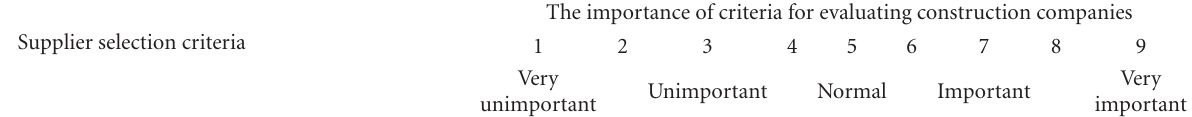
Table 1: Excerpt of the questionnaire for evaluating